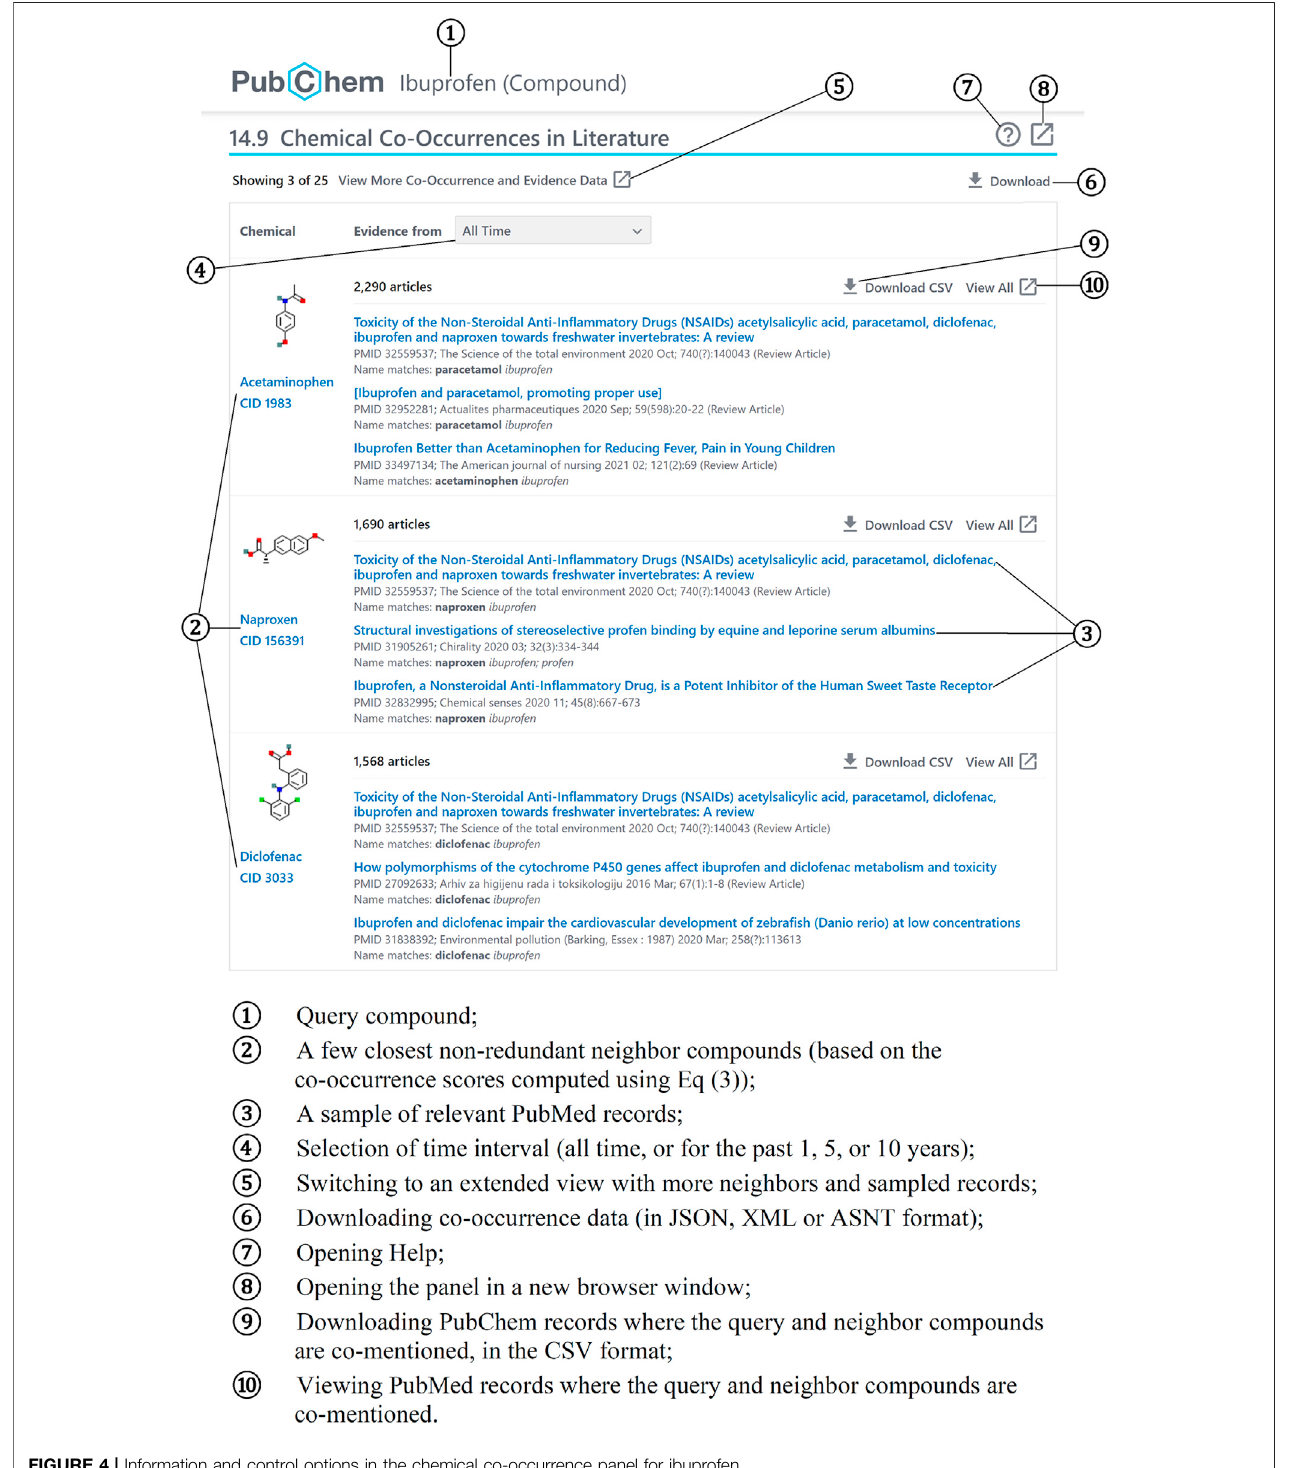
FIGURE 4 | Information and control options in the chemical co-occurrence panel for ibuprofen.